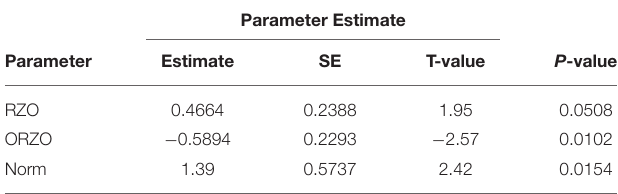
TABLE 2 | Win–loss records—defense first and home team.